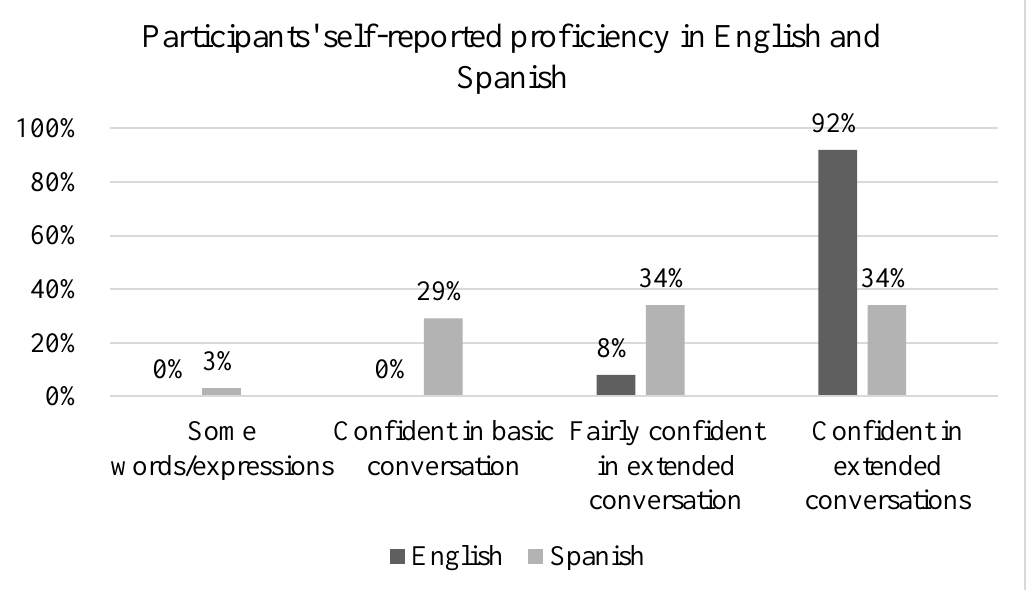
Figure 2. Participants’ self-reported proficiency in English and